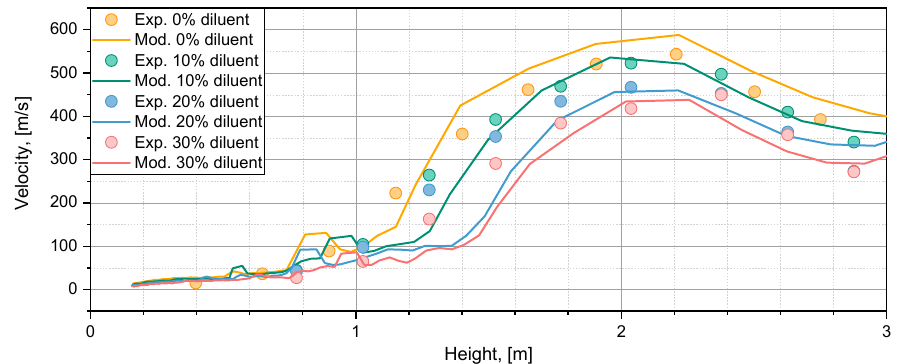
Figure 8. Comparison of velocity profiles for different mixtures (Bradley correlation) (experimental data [3] uncertainties not shown; they are of the mm/s order and would be indiscernible in the figure).